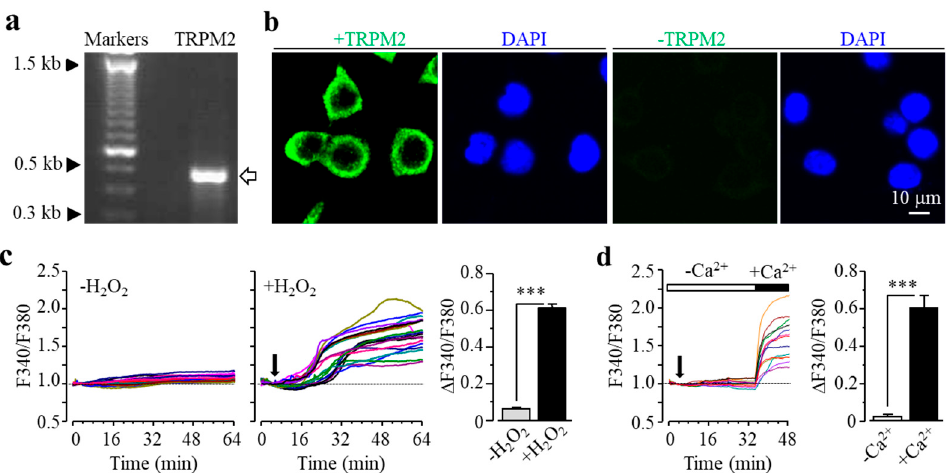
Figure 1. Transient receptor potential melastatin-related 2 (TRPM2) expression in BV2 microglial cells. ( a ) Agarose gel analysis showing TRPM2 mRNA expression (the arrow denotes the PCR product with the expected size of 479 bp). ( b ) Representative confocal images showing cells stained with the TRPM2 antibody and 4’,6-diamidino-2-phenylindole (DAPI) (left) or stained only with the second antibody and DAPI (right). ( c ) Left: F340/F380 in individual cells without or with exposure to 300 μ M H 2 O 2 (indicated by the downward arrow). Right: mean change in F340/F380 after 30 min exposure to H 2 O 2 or equivalent time point (63 control cells and 78 H 2 O 2 -exposued cells). ( d ) Left: F340/F380 in individual cells during exposure to 300 μ M H 2 O 2 , firstly in extracellular Ca 2+ -free solution and then Ca 2+ -containing solution, indicated by the open and the solid bars above, respectively. Right: mean change in F340/F380 during exposure to H 2 O 2 in Ca 2+ -free and Ca 2+ -containing solutions (14 cells). *** p < 0.005 compared to indicated group.